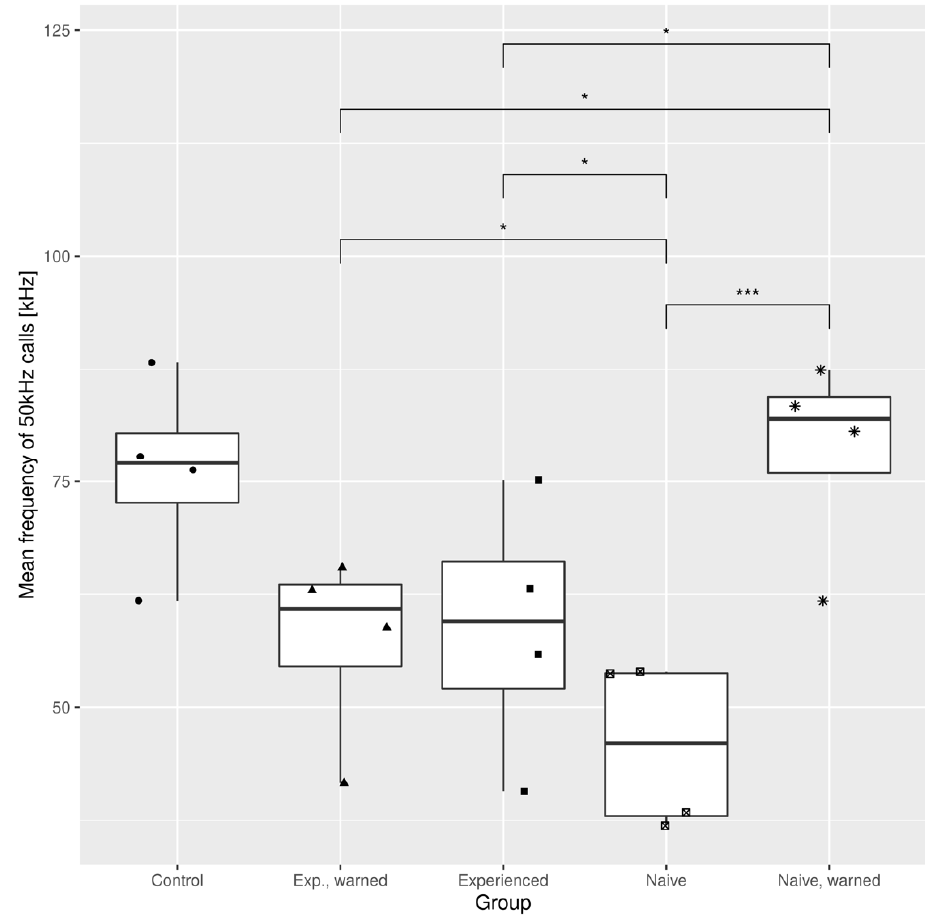
Figure 7. Mean frequency of 50 kHz calls in different experimental groups. Brackets mark significant differences identified by the Conover–Iman test. * p < 0.05; *** p < 0.001.